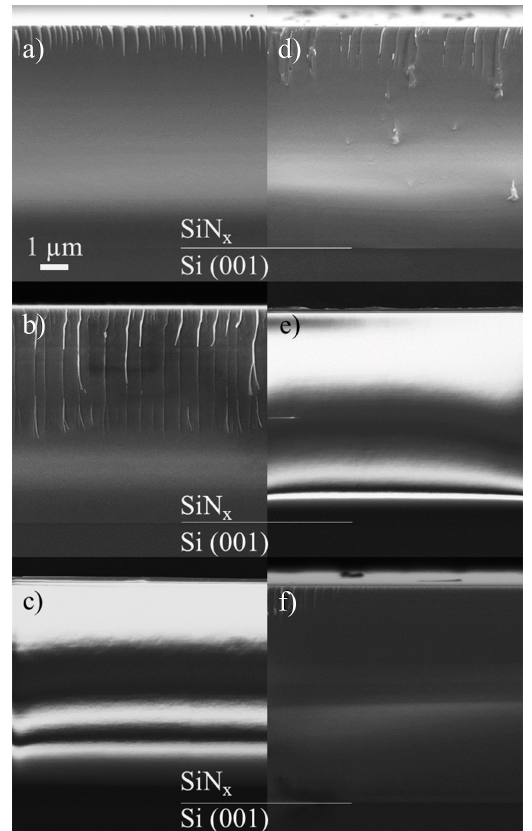
Figure 2. ( a – f ) Representative SEM cross-sections of coatings deposited onto Si(001) by ( a ) process 1; ( b ) process 2; ( c ) process 3; ( d ) process 4; ( e ) process 5; and ( f ) process 6. The Si(001)/SiN x interfaces are indicated.